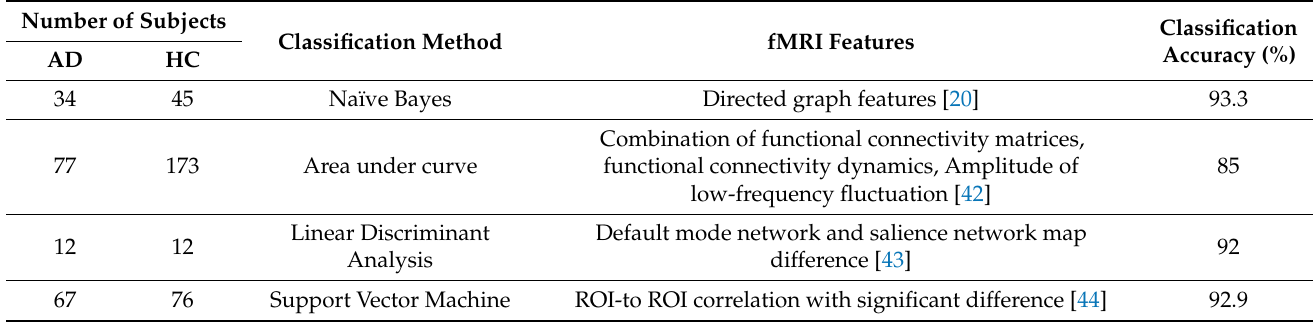
Table 11. Comparison of HC versus AD classification with recent works.